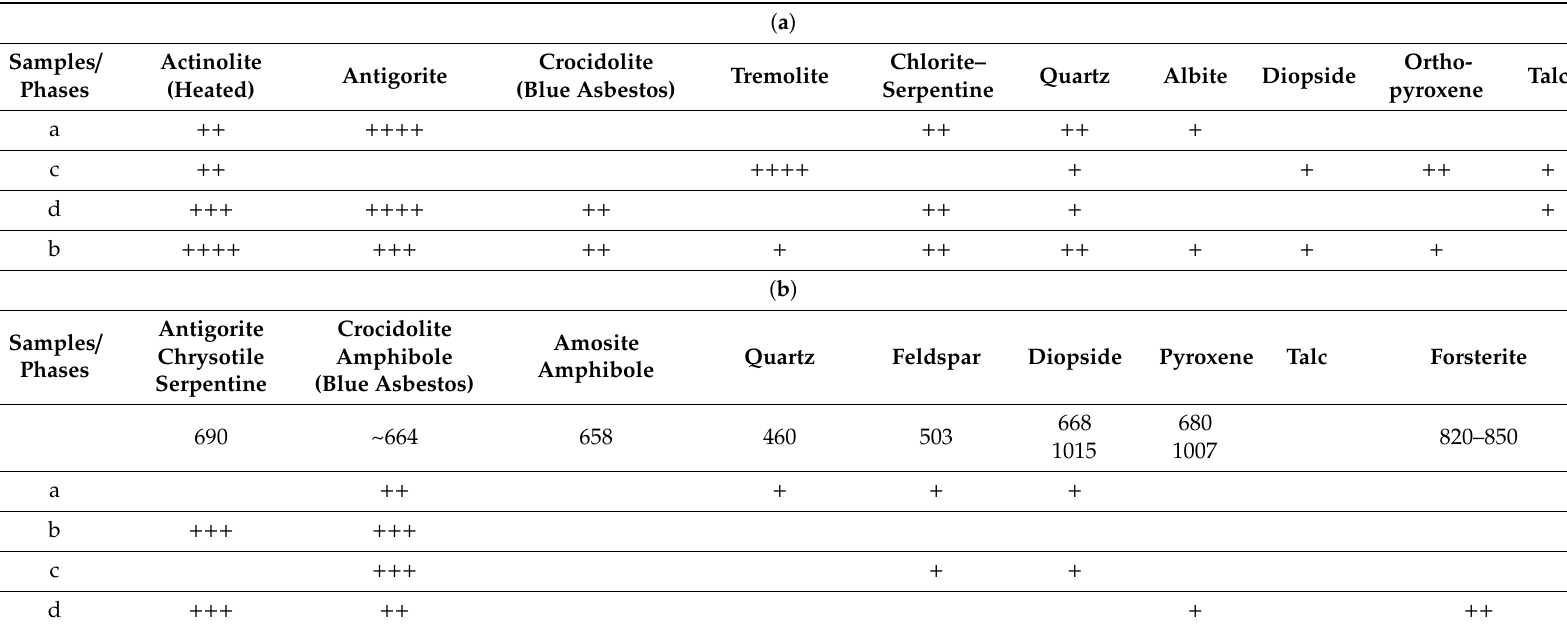
Table 2. ( a ) Phases identified by XRPD (estimation of the relative amounts: + , low; ++++ , high). ( b ) Phases identified by Raman spectroscopy. Characteristic peaks